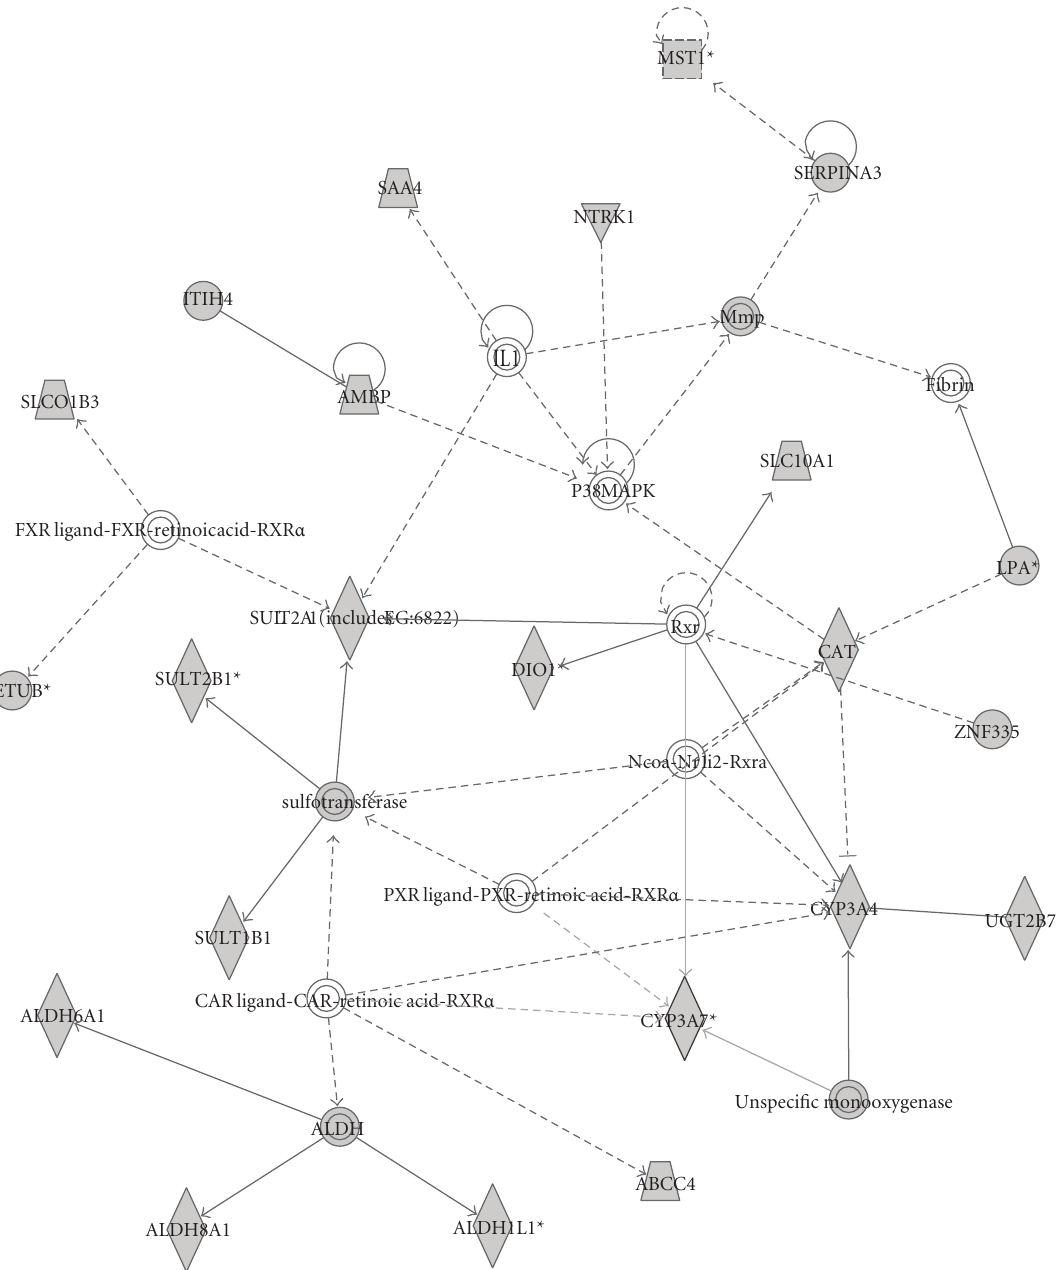
Figure 9: A network identified by Ingenuity Pathway Analysis of 23 liver-specific genes involved in small molecule biochemistry, drug metabolism, and lipid